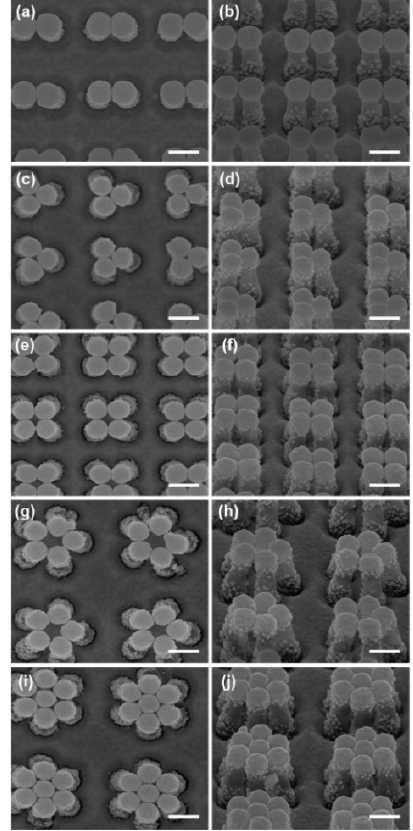
Figure 39. SEM image showing the top view ( a ) and the side view with a 45° angle from the normal (b) for digons. Analogous images are reported for trigon ( c , d ), tetragon ( e , f ), pentagon ( g , h ), and hexagon ( i , j ) structures. Scale bars in the SEM images are 200 nm. Reproduced with permission from Ou et al. [358]. Copyright (2011), the American Chemical Society.